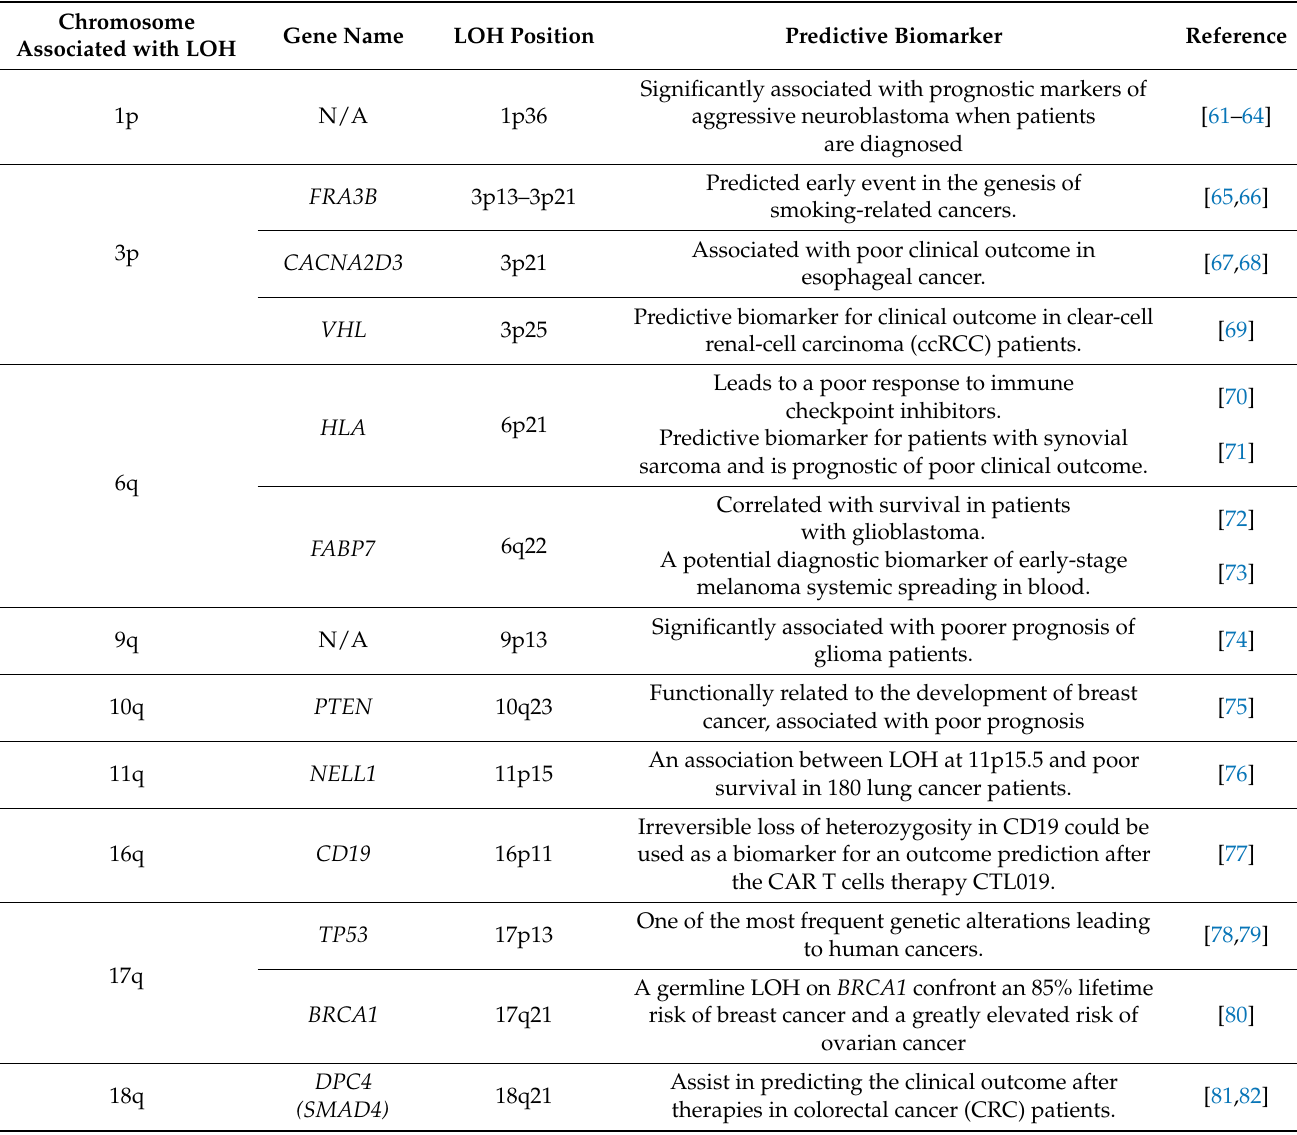
Table 1. Biomarkers on Chromosomes associated with